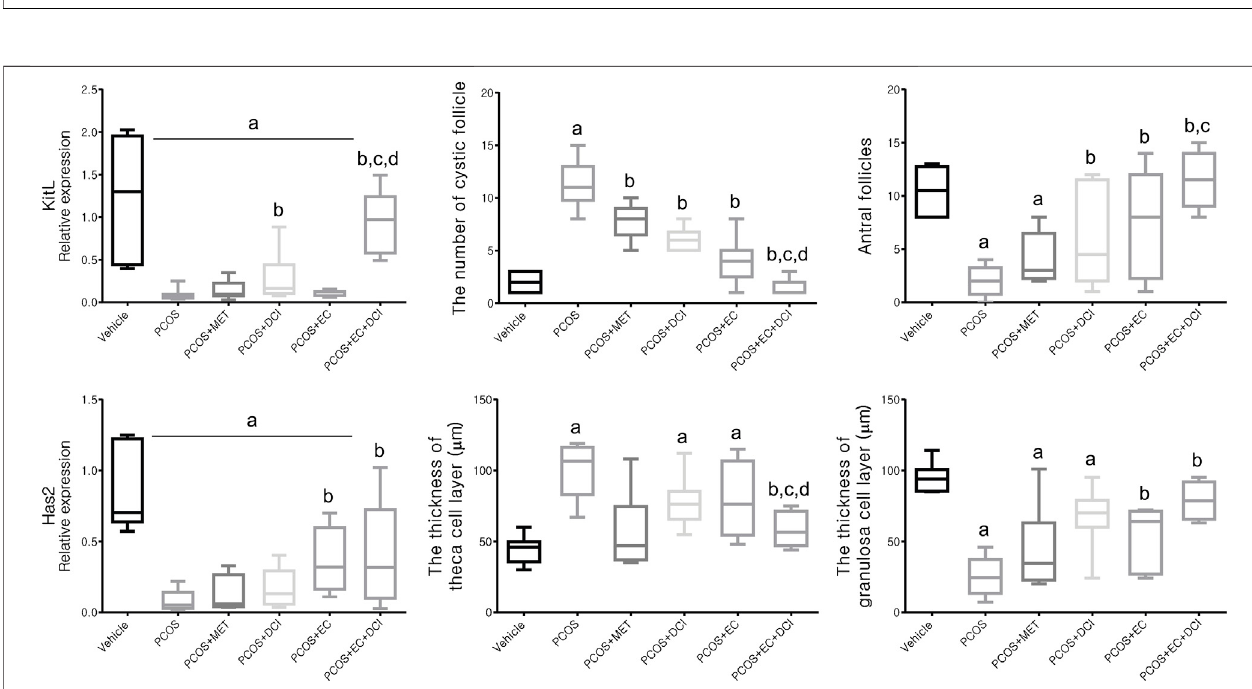
FIGURE4| EffectofECextractandDCIonserumlevelsinPCOSrats.Serumlevel(s)ofLH,FSH,TE2,TNF α andIL-6weremeasuredusingacompetitiveenzyme- linked immunosorbent assay (ELISA) kit. All values represent the mean ±SD. a p < 0.05 vs. vehicle, b p < 0.05 vs. PCOS, c p < 0.05 vs. PCOS + DCI, d p < 0.05 vs. PCOS + EC. MET, Metformin; EC, Ecklonia cava K.; DCI, d-chiro inositol.